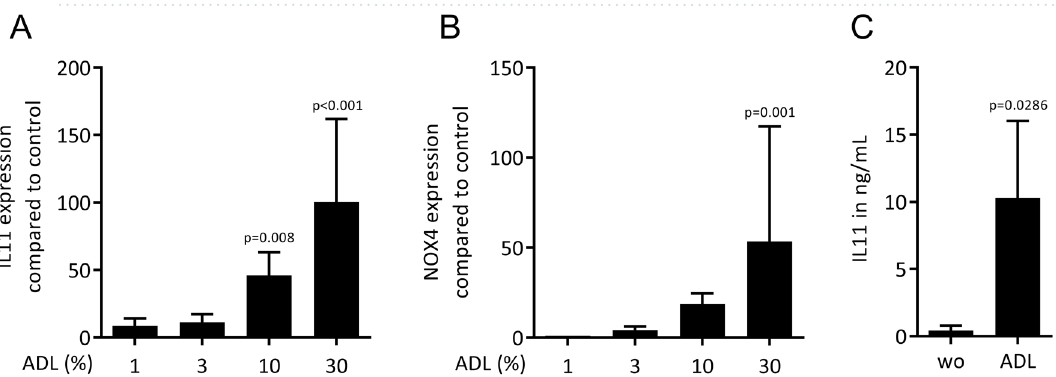
Figure 4. The effect of ADL on IL11 and NOX4 expression is dose-dependent. Gingival fibroblasts were incubated with various concentrations of ADL. Reverse transcription PCR analysis for ( A ) IL11 and ( B ) NOX4. Statistic was based on multiple comparison one-way ANOVA. ( C ) Quantification of IL11 in the supernatant by immunoassay. N = 3–4. Data are presented as mean ± SD. Statistic was based on two-tailed Mann–Whitney of significance at around 10% ADL (Fig. 4A, B). That was confirmed at the protein level by an IL11 immunoassay (Fig. 4C). ADL from human teeth also increased IL11 expression in gingival fibroblasts (unpublished observa- tion). The inhibitor for the TGF ‐ β RI kinase, SB431542 blocked the increased expression of IL11 and NOX4 in the presence of ADL (Fig. 5A, B). Activation of TGF ‐ β signaling was validated by Western blot and immuno- fluorescence showing an increased phosphorylation of smad3 (Fig. 6A) and a translocation of smad2/3 to the nucleus (Fig. 6B), respectively. Overall, these findings indicate a clear activation of TGF-β signaling pathway by ADL at different molecular levels.